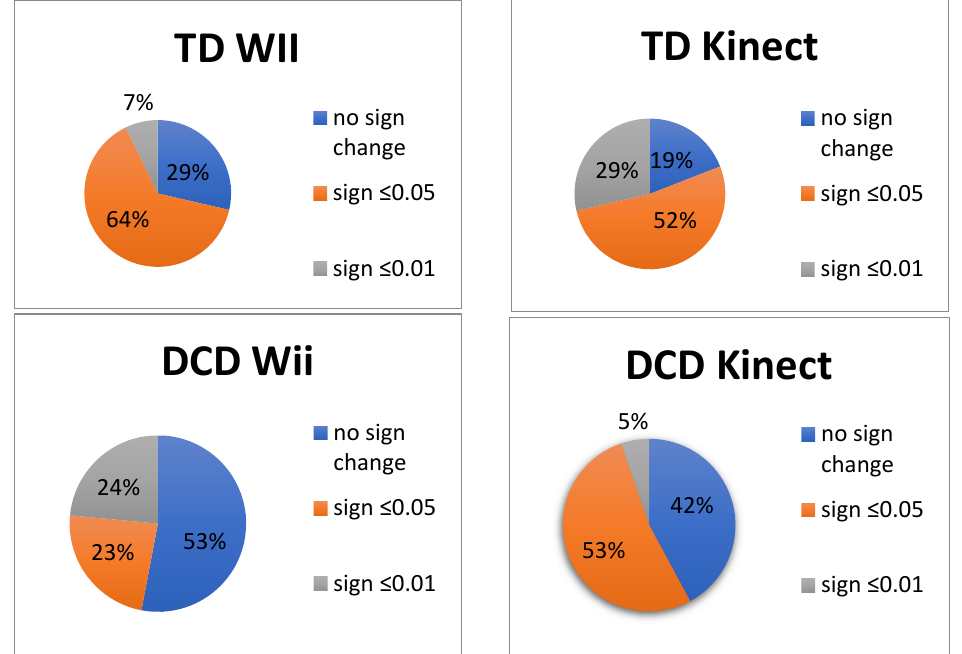
Figure 1. Performance in mean percentage of normalized game scores over five weeks between Wii Fit and Xbox Kinect per participant group.